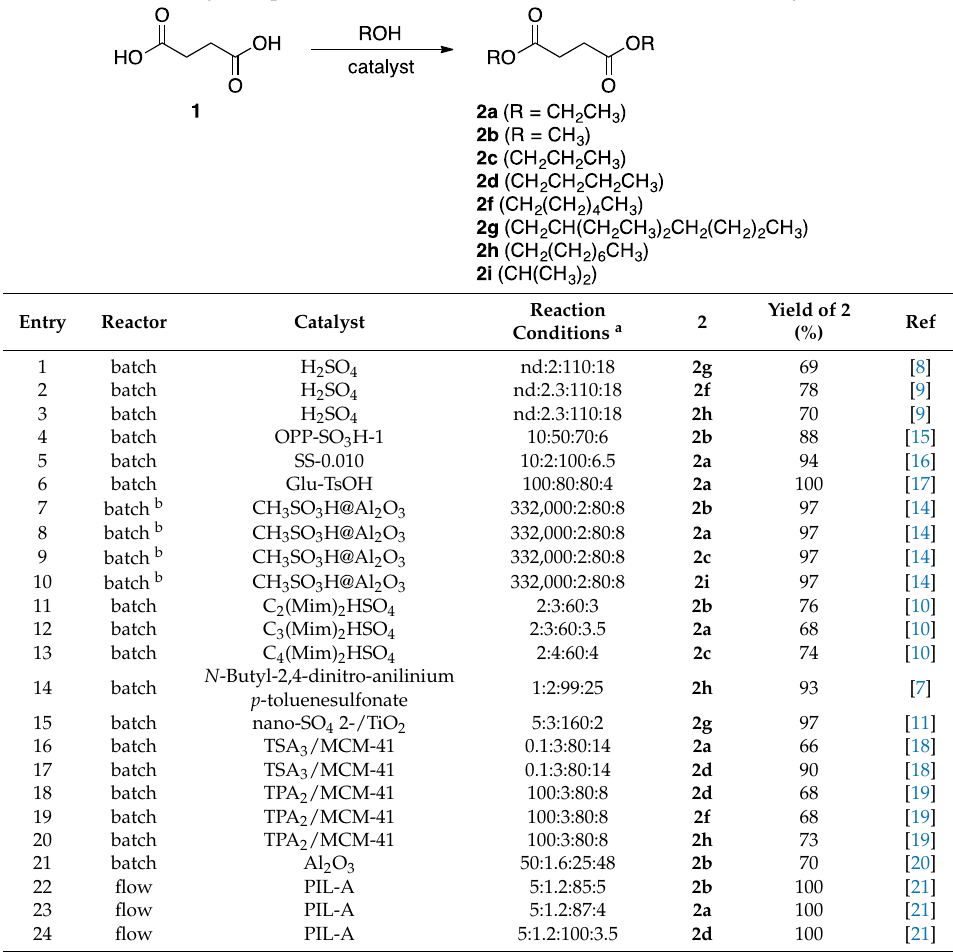
Table 1. Selected catalysts reported for the conversion of succinic acid ( 1 ) to dialkylsuccinates 2.